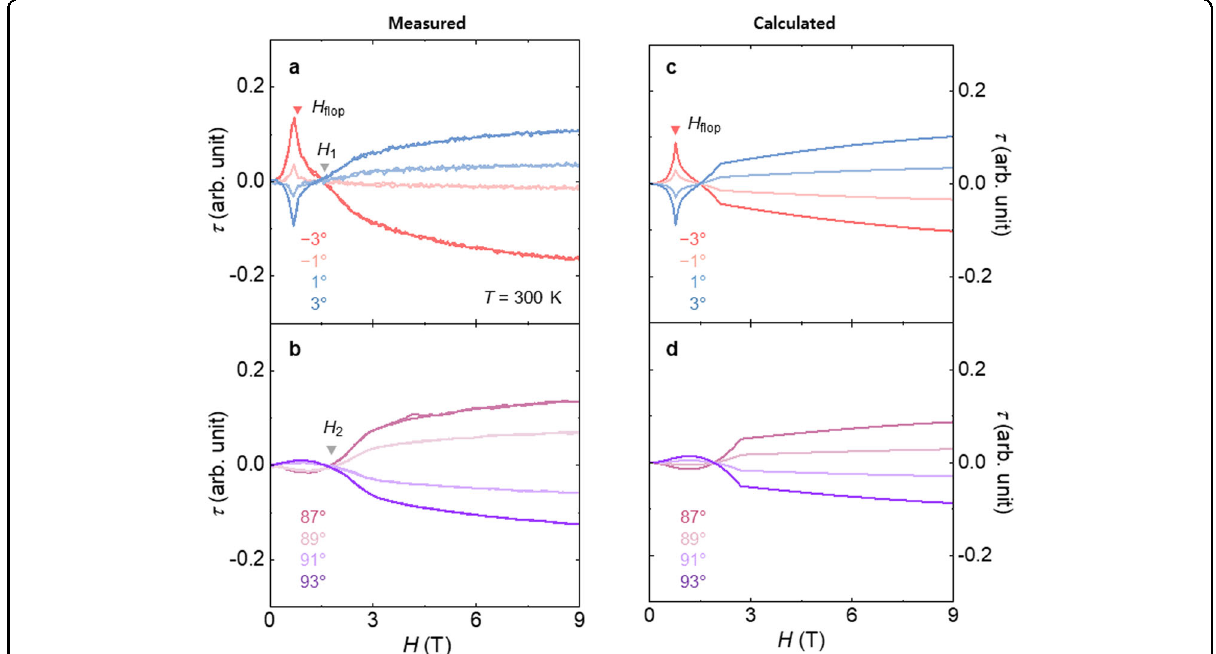
Fig. 3 Anisotropic magnetic torques at room temperature. a H dependence of the magnetic torque, τ , measured at θ = − 3, − 1, 1, and 3° for T = 300 K. The red and gray inverted triangles indicate the occurrence of spin fl ops at H fl op and crossing of the zero τ value at H 1 , respectively. b H dependence of τ measured at θ = 87, 89, 91, and 93° for T = 300 K. The gray inverted triangle denotes the crossing of the zero τ value at H 2 . c Calculated H -dependent τ for θ = − 3, − 1, 1, and 3°. d Calculated H -dependent τ for θ = 87, 89, 91, and